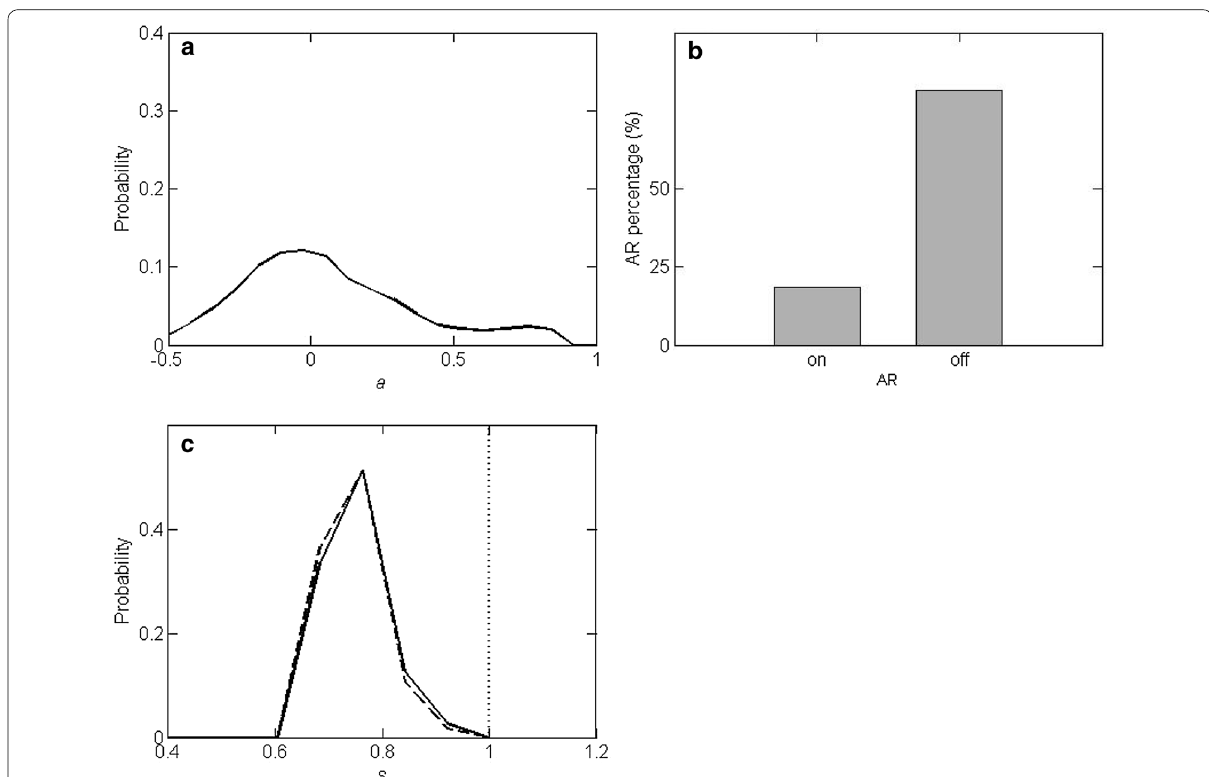
Fig. 10 Posterior error results for the COPROD1 data. a , c are the 1D marginal distributions for the first-order autoregressive parameter a and error scale hyperparameter s , respectively, with (solid lines) and without (dashed lines) considering error correlations, and ( b ) indicates the portions of AR(1)-on and AR(1)-off rjMCMC